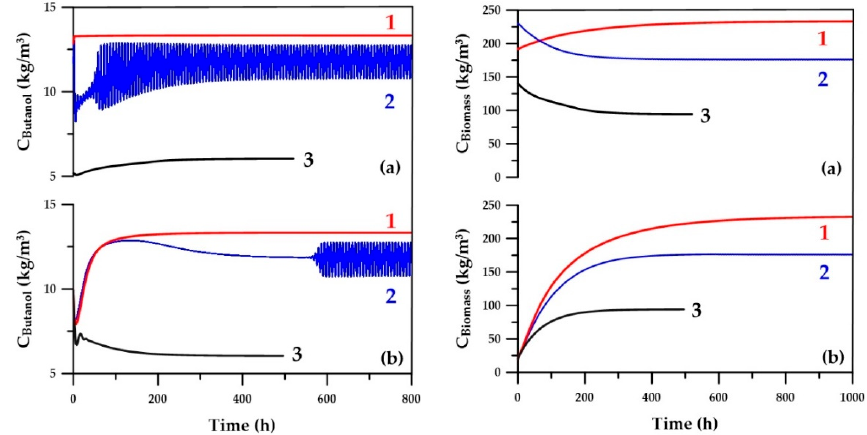
Figure 12. Butanol and biomass concentration as a function of time with ( a ) initial concentrations predicted by ANNs and ( b ) arbitrary initial concentrations. (1) Best ranked solution; (2) medium-ranked solution; (3) lowest-ranked solution.